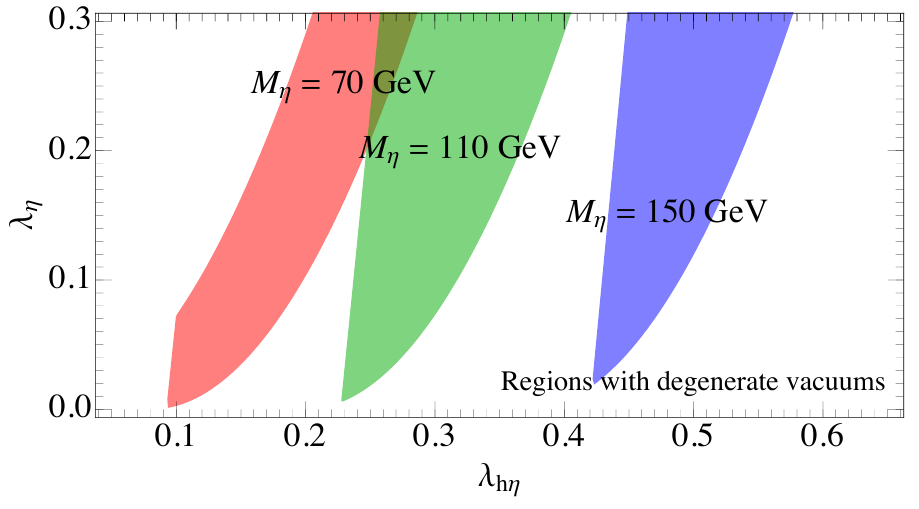
Figure 1 . The parameter space giving degenerate